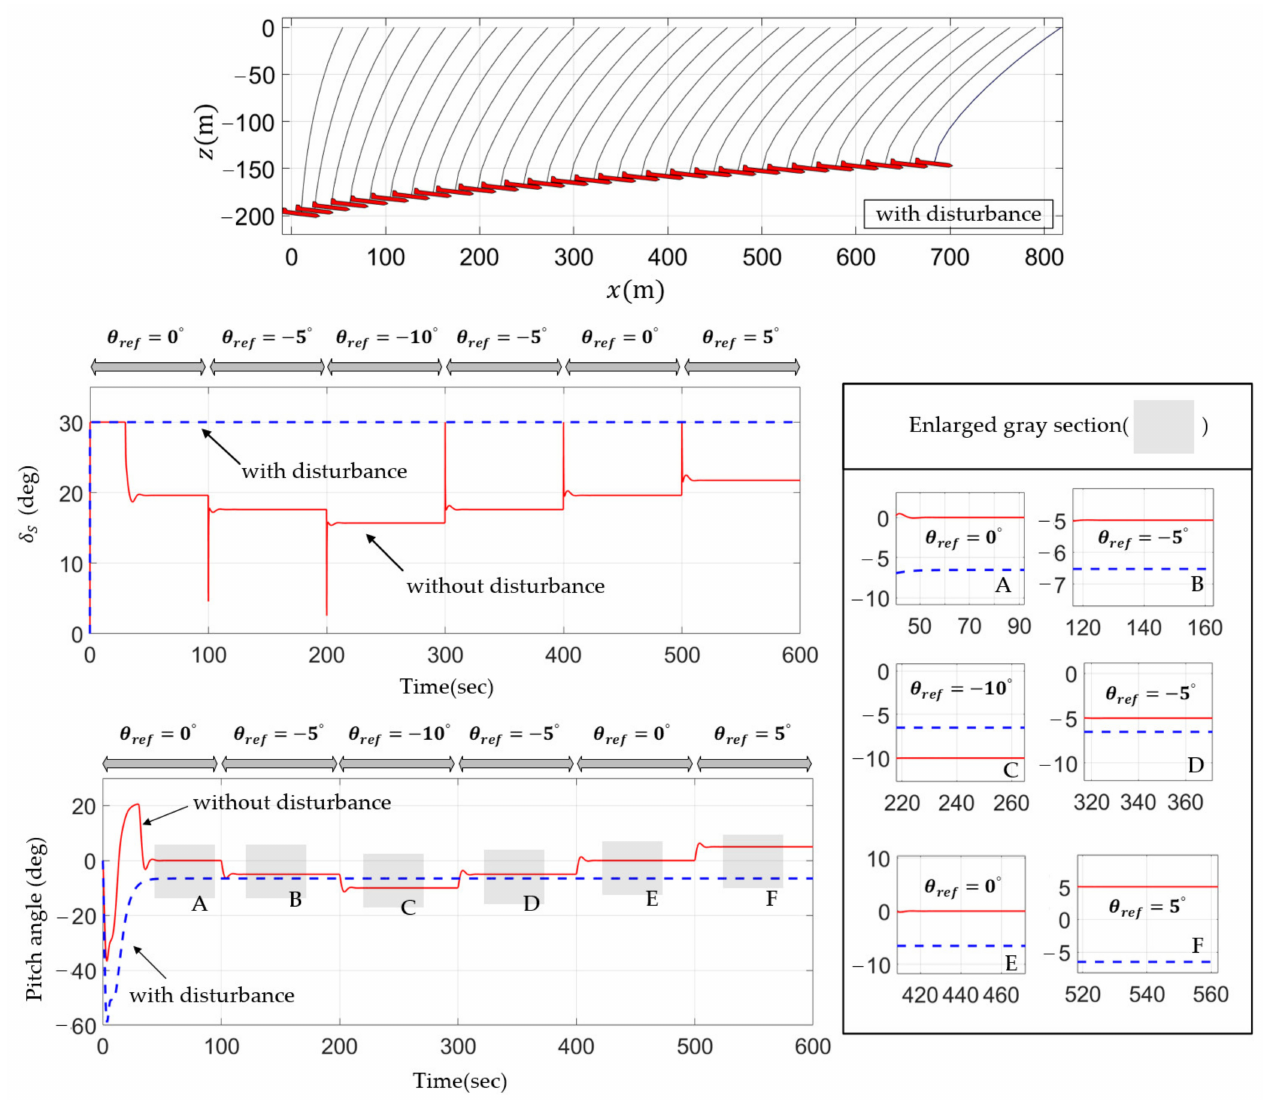
Figure 13. Simulation results when − 200 Nm disturbance is applied for Case